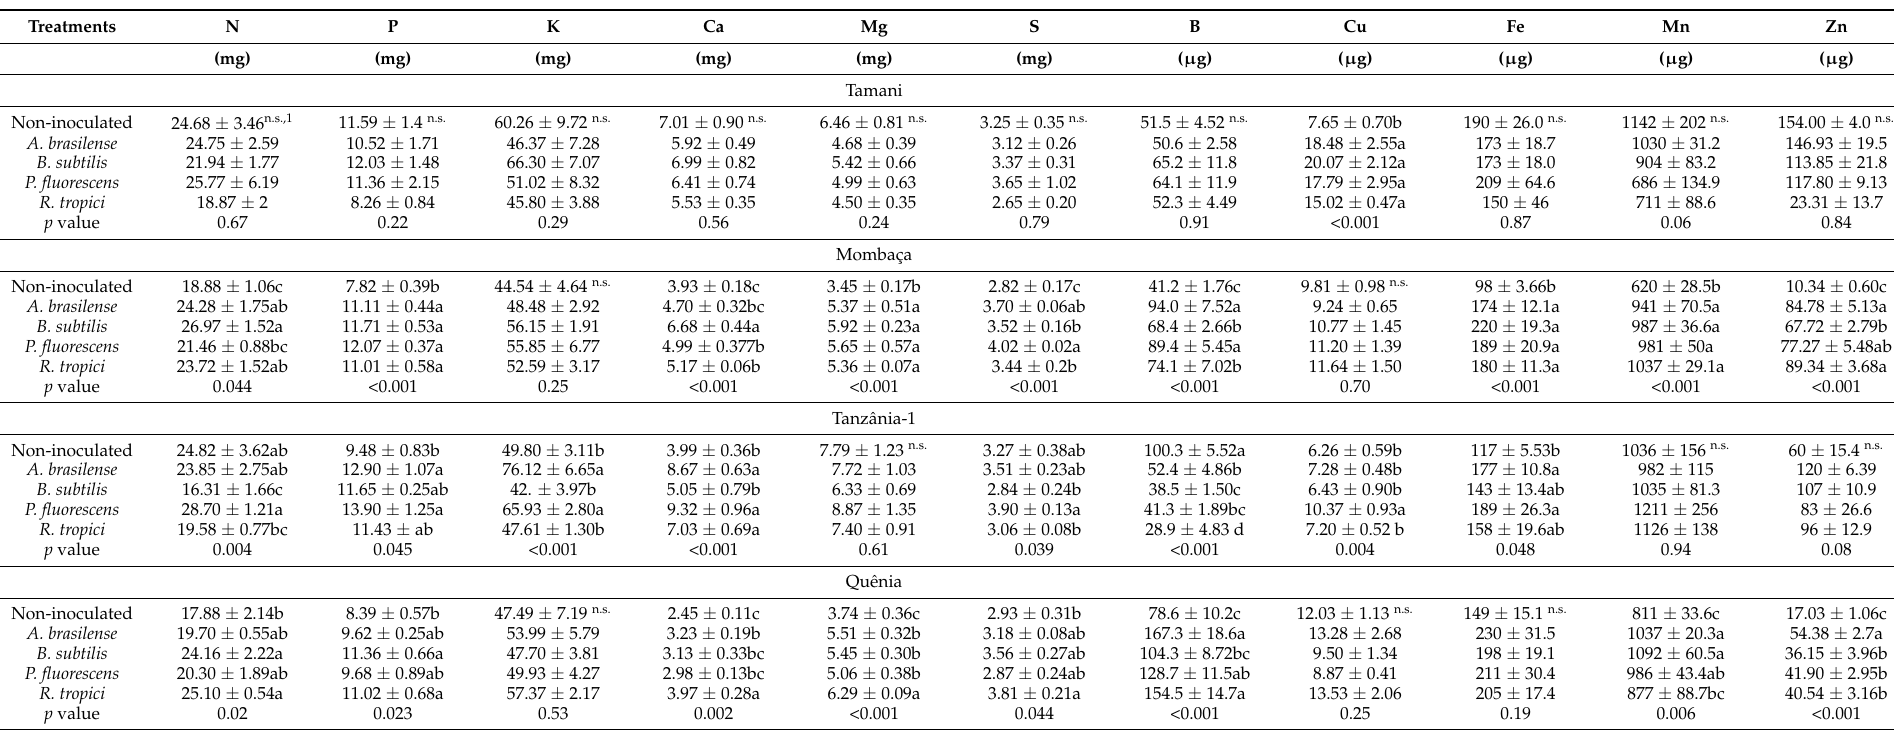
Table 2. Total nutrient contents in the shoots of six Megathyrsus maximus cultivars (Tamani, Mombaça, Tanz â nia-1, Qu ê nia, Massai, and Zuri) either inoculated with Azospirillum brasilense (CNPSo 2083 + CNPSo 2084), Bacillus subtillis (CNPSo 2657), Pseudomonas fluorescens (CNPSo 2719), or Rhizobium tropici (CNPSo 103), or remaining non-inoculated (control). The experiment was carried out under greenhouse conditions in a sterile substrate and plants were sampled 35 days after